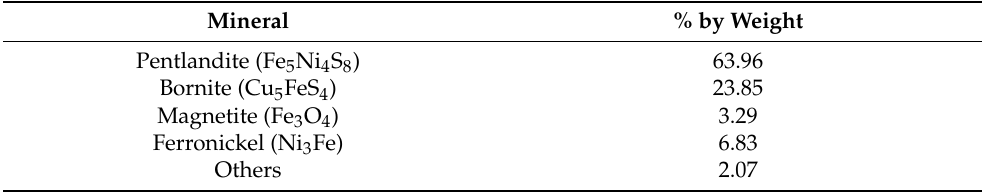
Table 3. Mineralogical composition (wt%) of the low-nickel